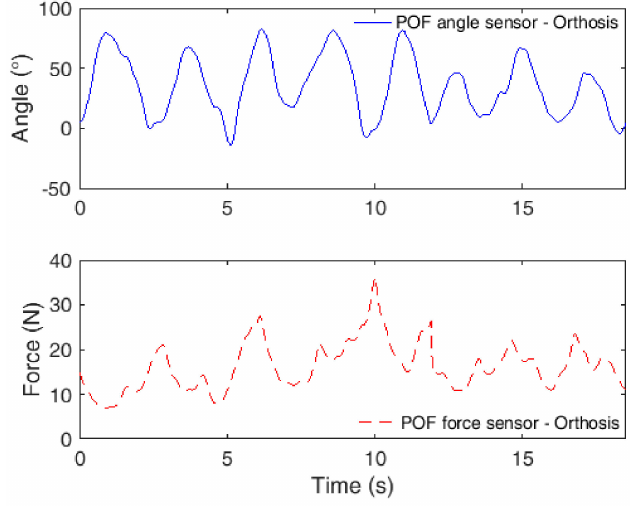
Figure 6. POF sensor responses in robot-assisted rehabilitation using an orthosis for flexion / extension